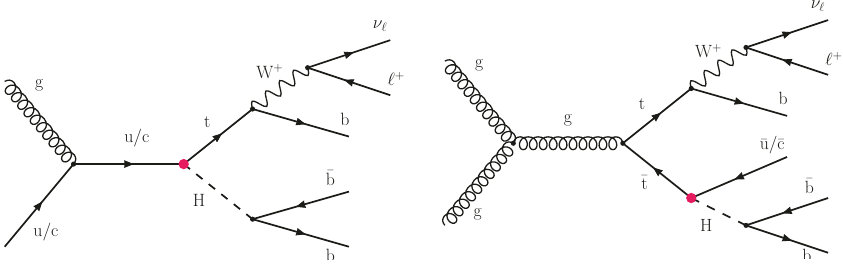
Figure 1 . Representative Feynman diagrams for FCNC tH processes: associated production of the top quark with the Higgs boson (left), and FCNC decay of the top antiquark in tt events (right). The FCNC vertex is indicated by the